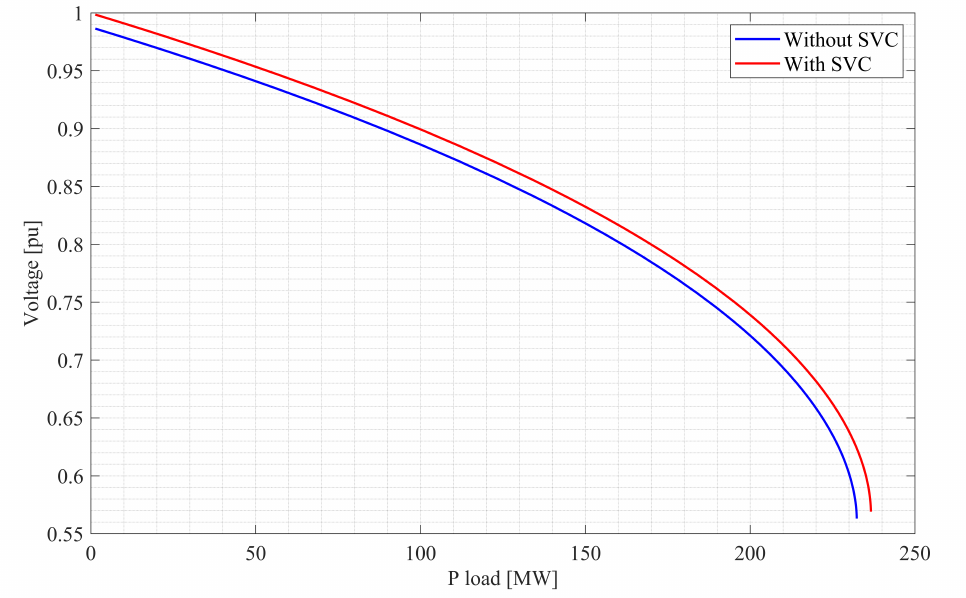
Figure 5. PV curve in the IEEE 9-bus bar